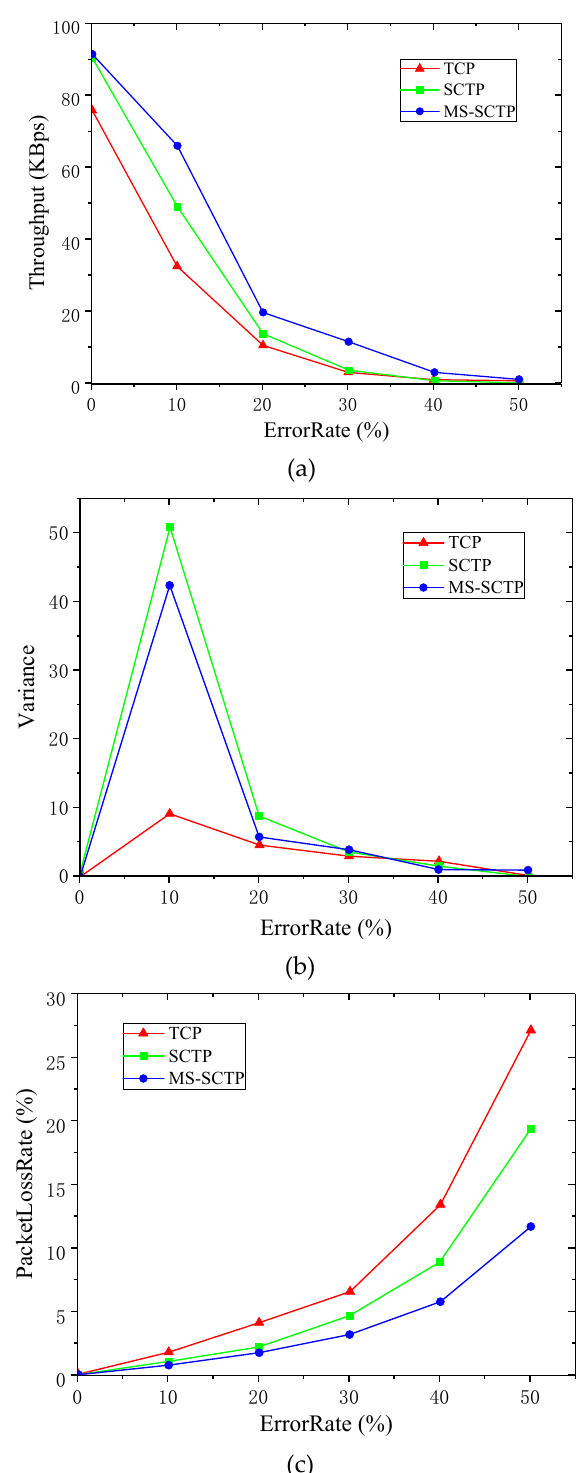
Figure 8. Comparison of three schemes’ performances. ( a ) Average throughput; ( b ) throughput variance; ( c ) packet loss rate.